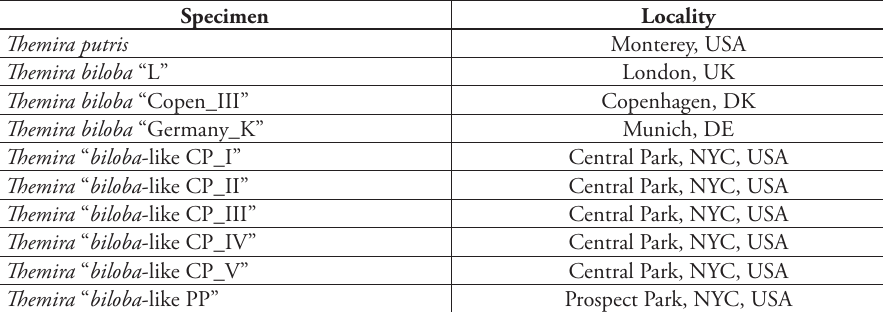
Table 1. Details of specimens used in molecular